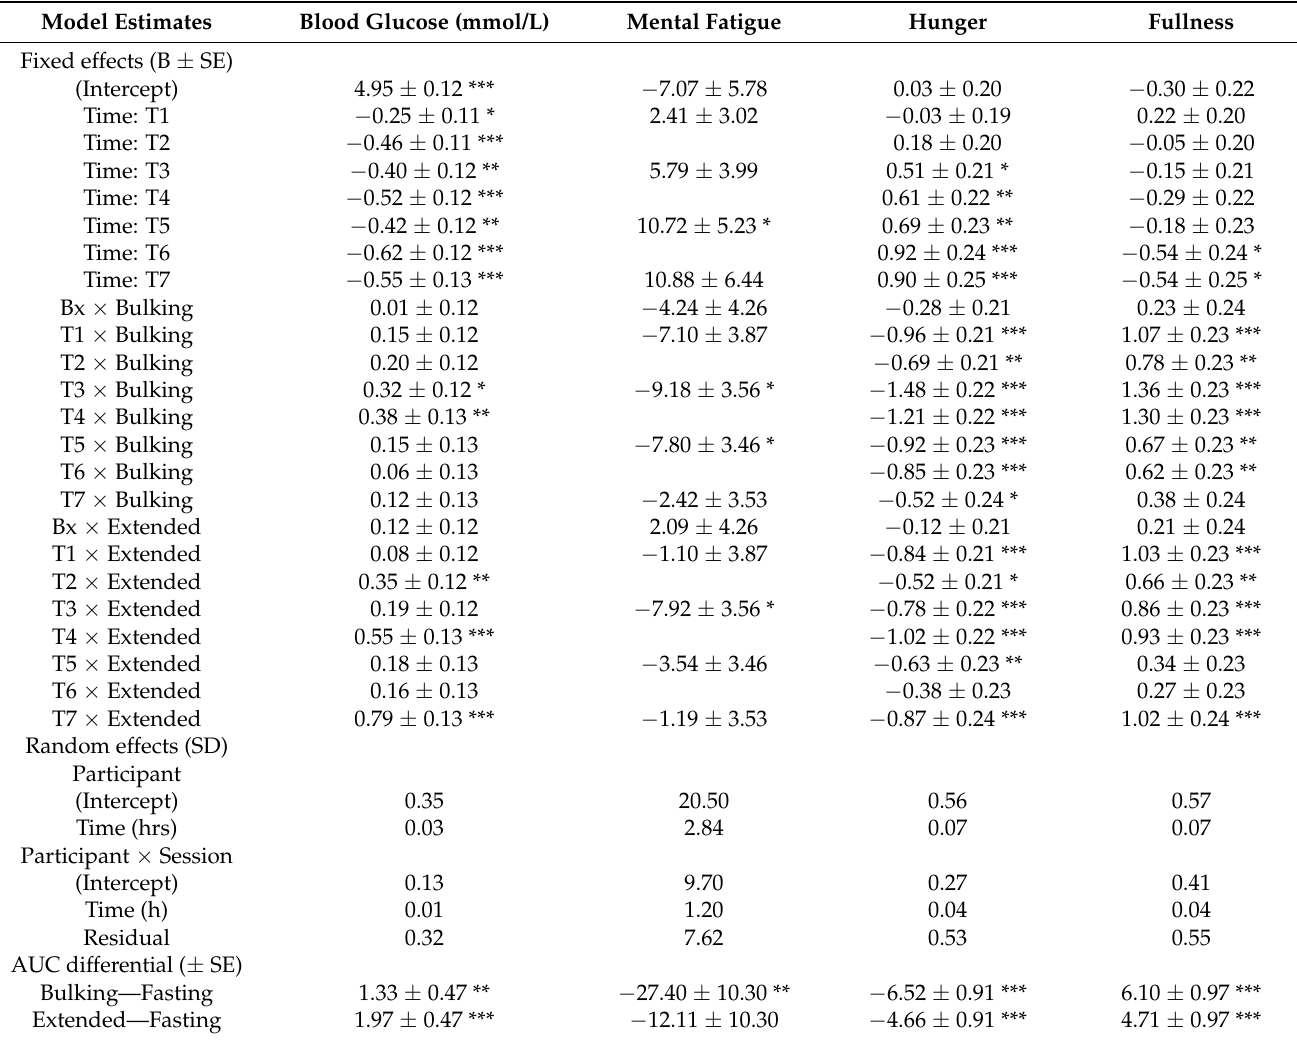
Table 4. Linear mixed effect model estimates and AUC differentials for blood glucose, mental fatigue, hunger and fullness. Model Estimates